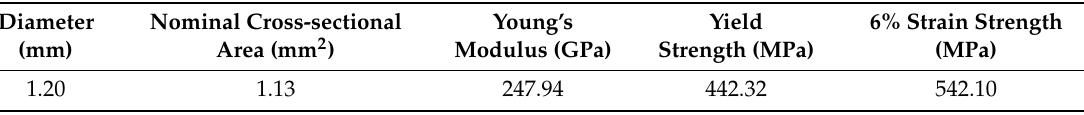
Figure 2. Stress–strain curves of SMA wire. Table 1. Mechanical properties of 1.20 mm SMA wire materials.